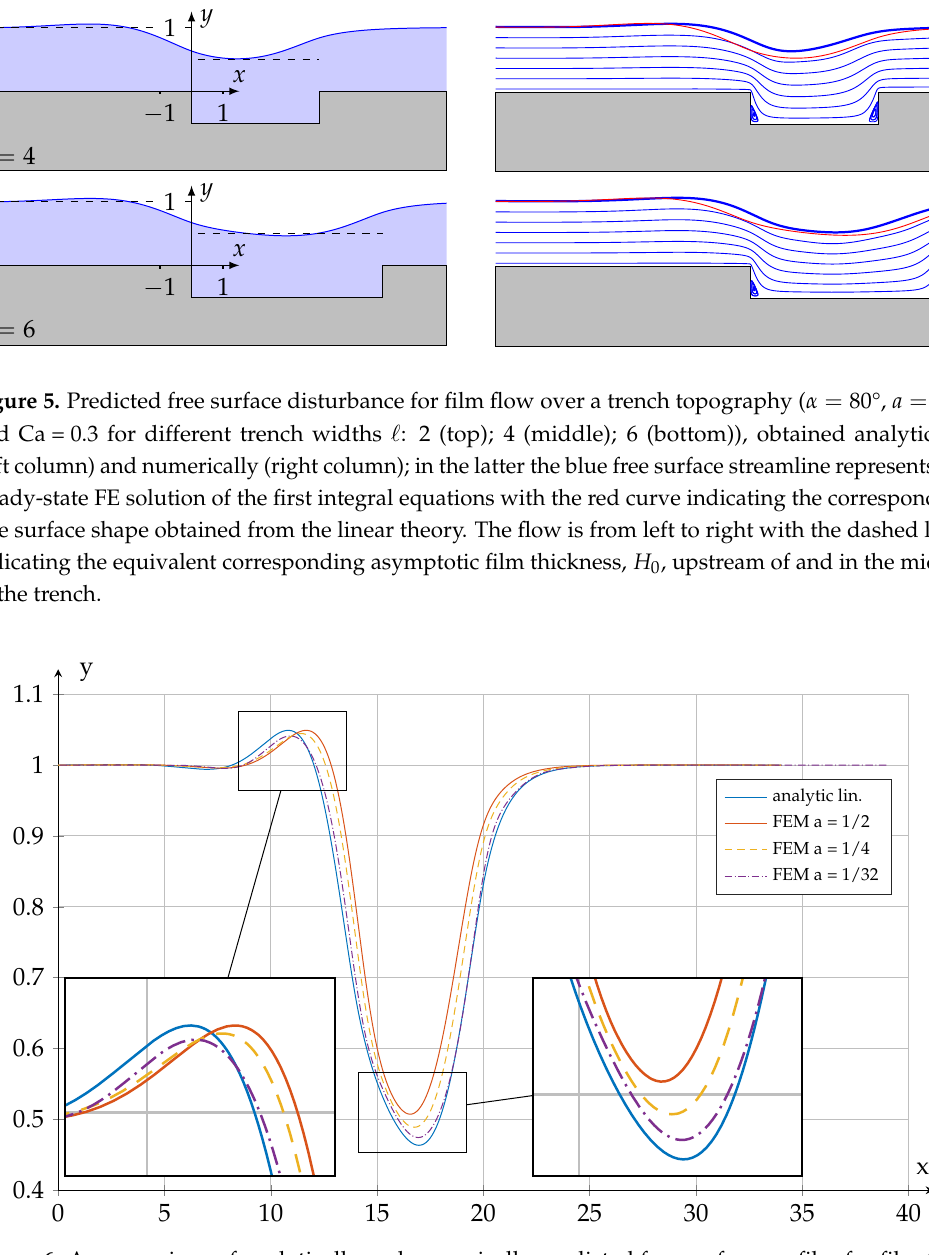
Figure 6. A comparison of analytically and numerically predicted free surface profiles for film flow over a trench (located between x = 17 and x = 23) with α = 80 ◦ , Ca = 0.3, (cid:96) = 6 for varying trench depth a . The superimposed inserts are magnified by a factor